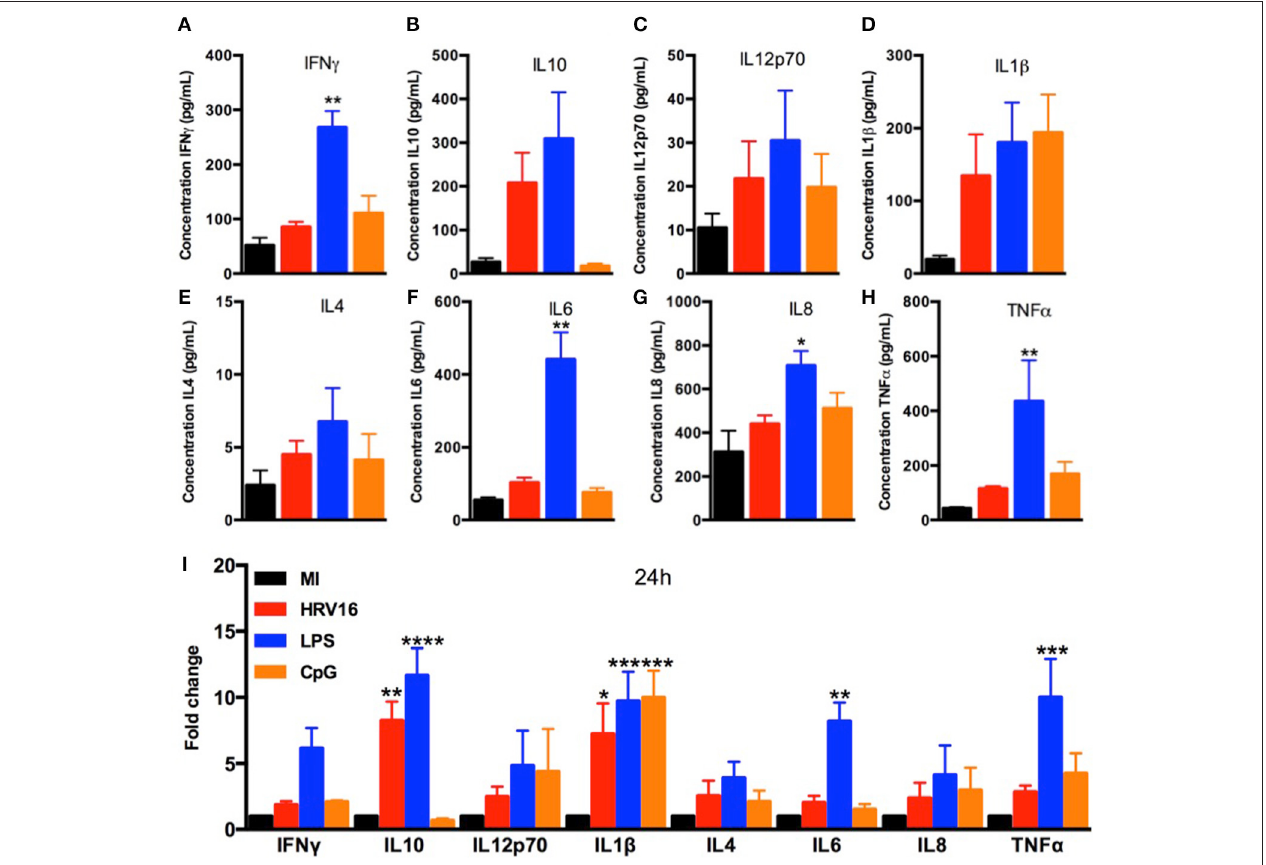
FIGURE 2 | Human macrophages secrete pro-inflammatory and regulatory cytokines in response to LPS and CpG. Human macrophages were exposed to HRV16 (red bars), LPS (blue bars), CpG (orange bars) or MI (black bars) for 1h and rested overnight. Supernatants were collected and analyzed by MSD. MSD results for (A) IFN γ , (B) IL10, (C) IL12p70, (D) IL1 β , (E) IL4, (F) IL6, (G) IL8, (H) TNF α . * p < 0.5, ** p < 0.01 Kruskal Wallis Test with Dunn’s Post Test vs. MI. (I) Relative fold changes for cytokine production in HRV16, LPS and CpG exposed human macrophages vs. MI. ** p < 0.01, *** p < 0.001, **** p < 0.0001 Two Way Anova with Dunnett’s Post Test vs. MI. Error bars represent standard error of the mean (SEM). n = 4 independent experiments on different donors.